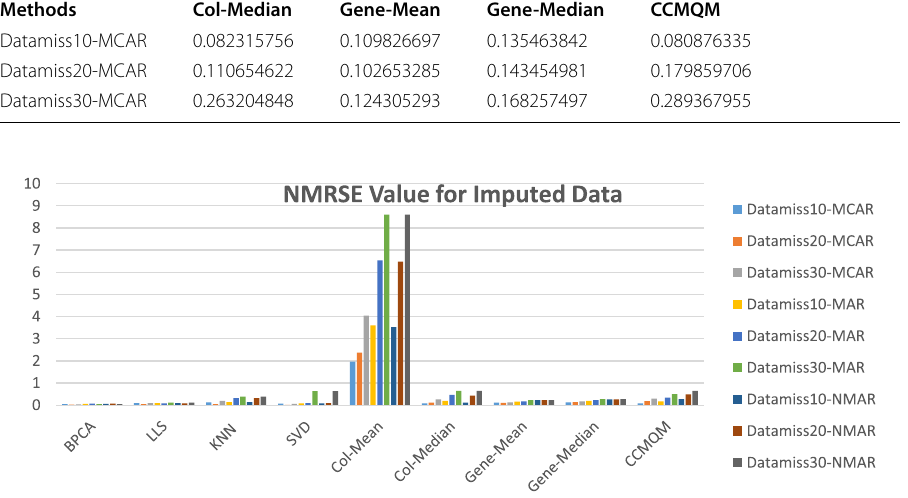
Fig. 1 Normalized root mean square error of the imputation